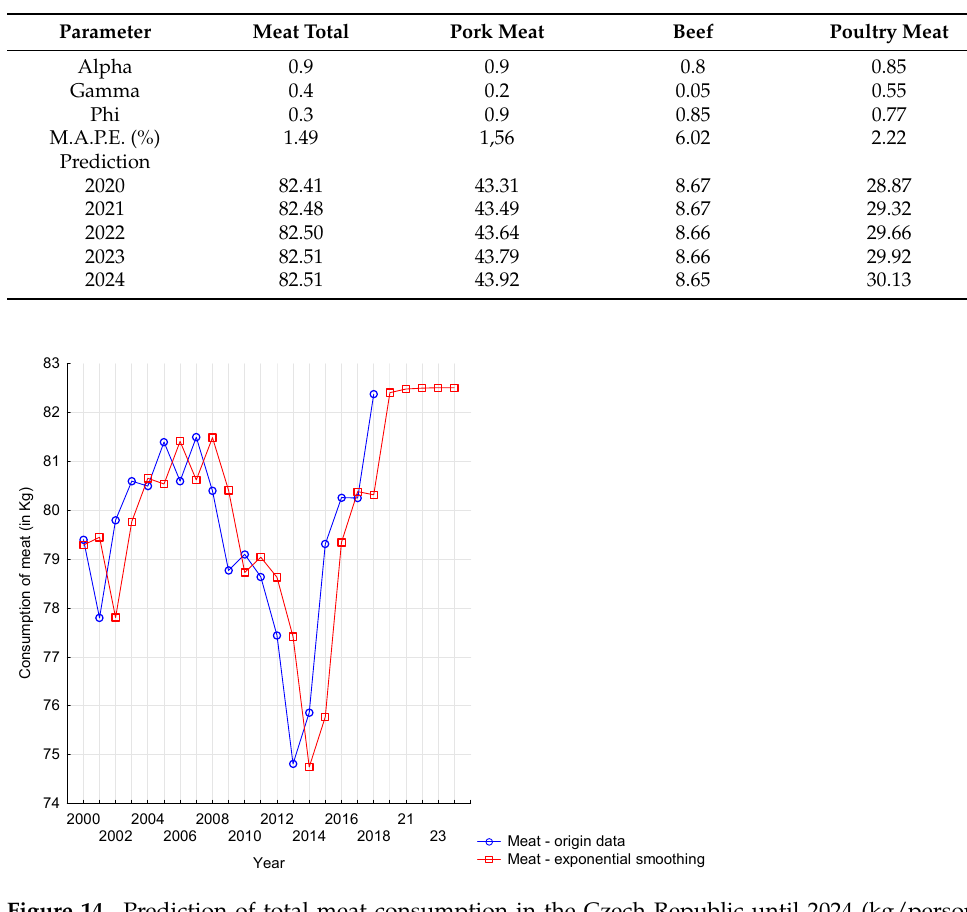
Figure 16. Prediction of beef consumption in the Czech Republic until 2024 [27].